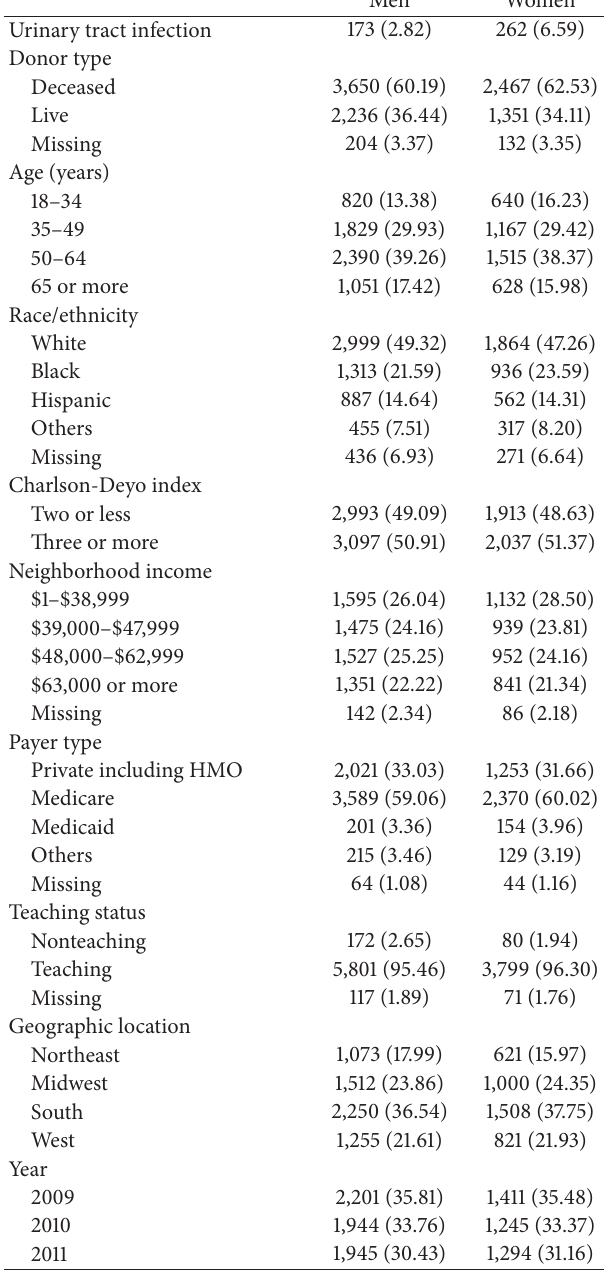
Table 1: Characteristics of study population ( 𝑛 , weighted %),